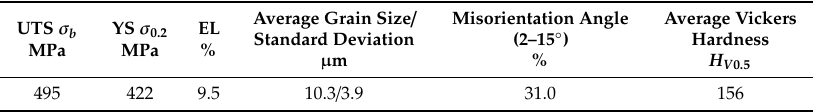
Table 2. Mechanical properties and grain size of forged plate